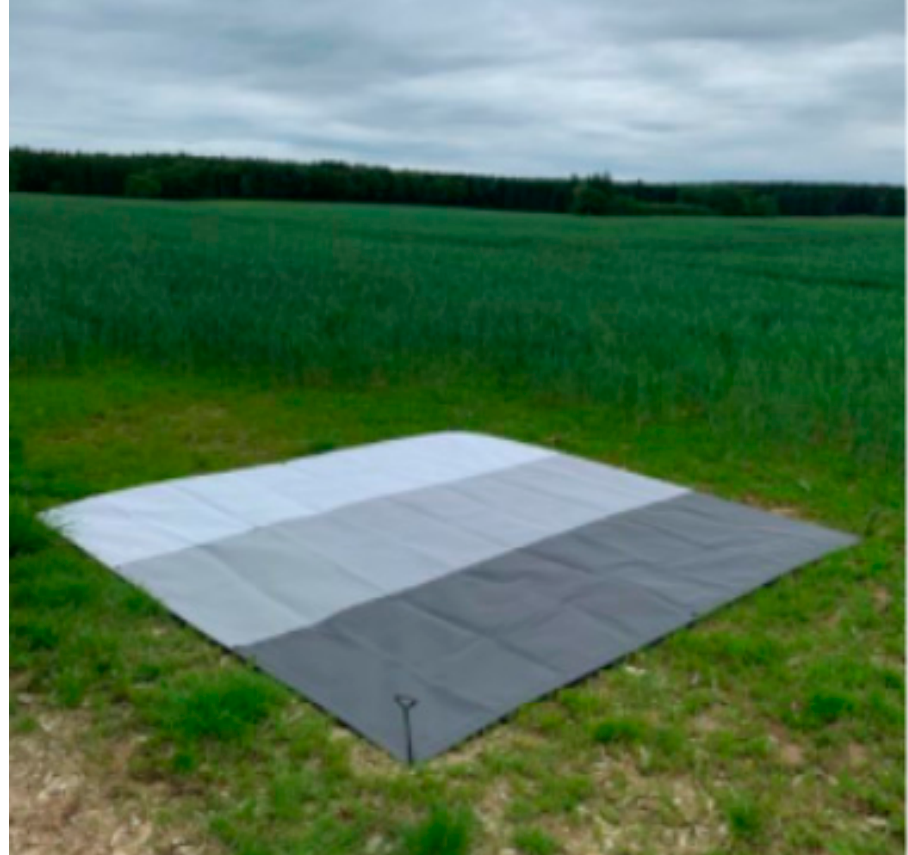
Figure 8. Tarp with the three gray reflection levels deployed at the interest area, used for radiometric Figure 8. calibration.